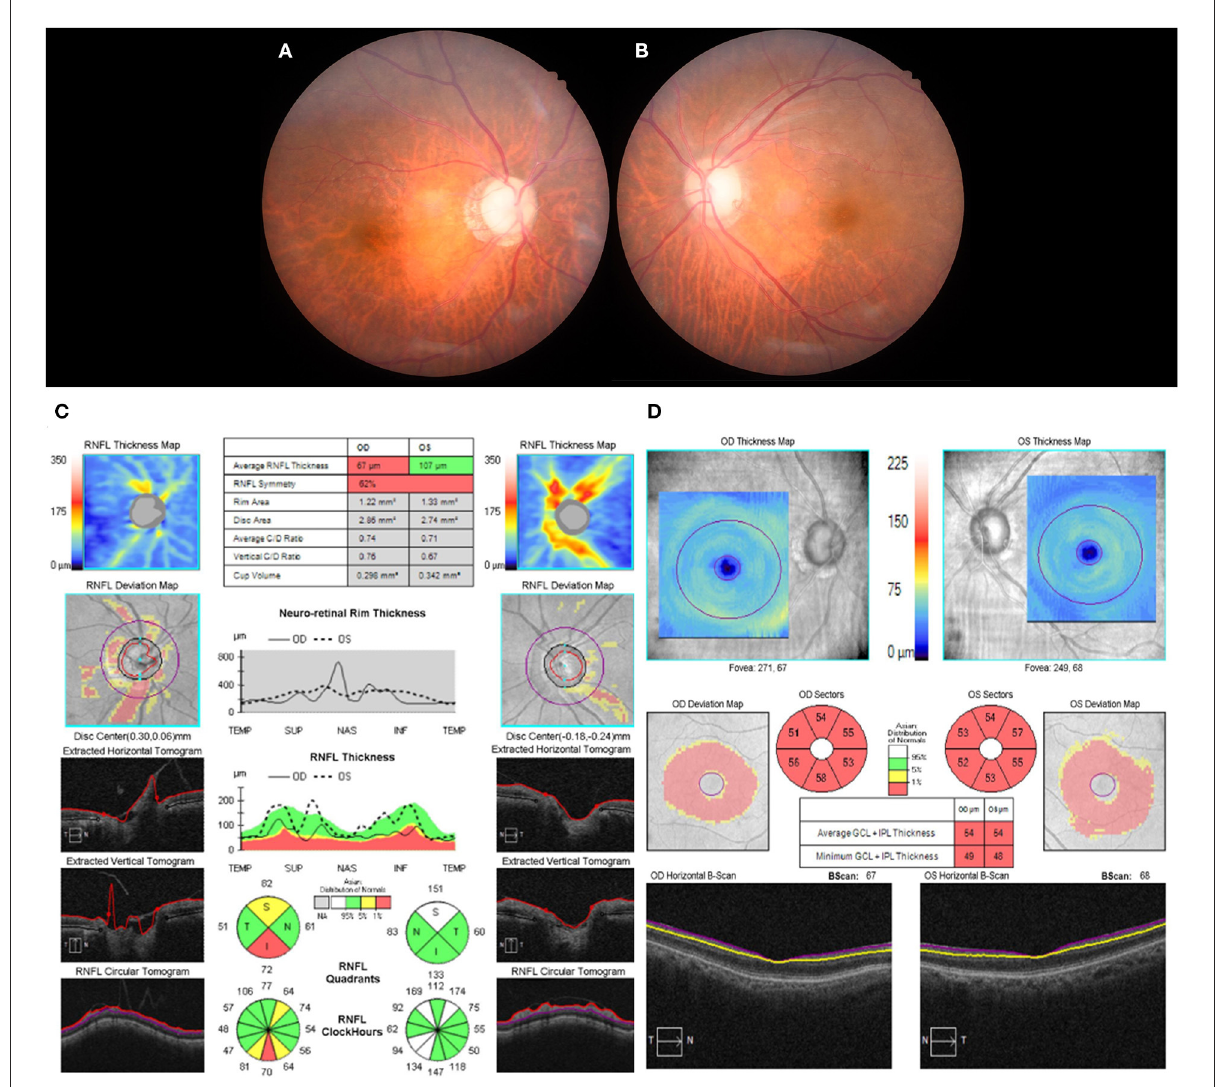
FIGURE3 Follow-up fundus photography showed pale and atrophic disc in both eye (A,B) , and cptical coherence tomography (OCT) retinal nerve fiber layer (RNFL) analysis showed normal RNFL thickness in the left eye but RNFL thinning in the right eye (C) . The thickness of the ganglion cell complex (GCC) demonstrated severe thinning in both eyes (D)